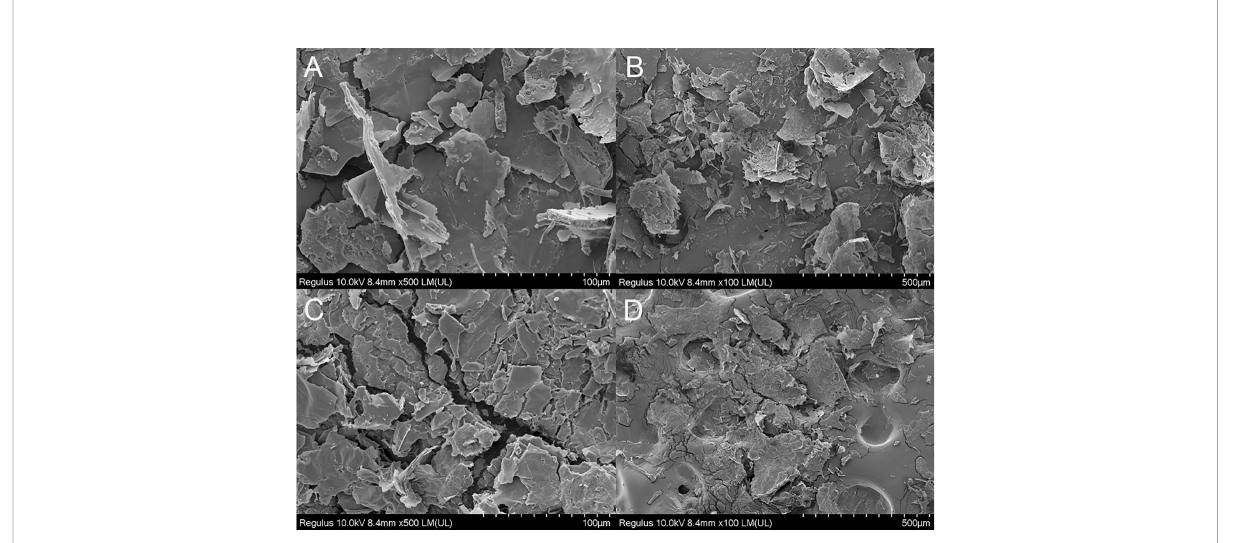
FIGURE 2 SEM images (magni fi cation 100× and 500×). (A, C) (100 µm); (B, D) (500